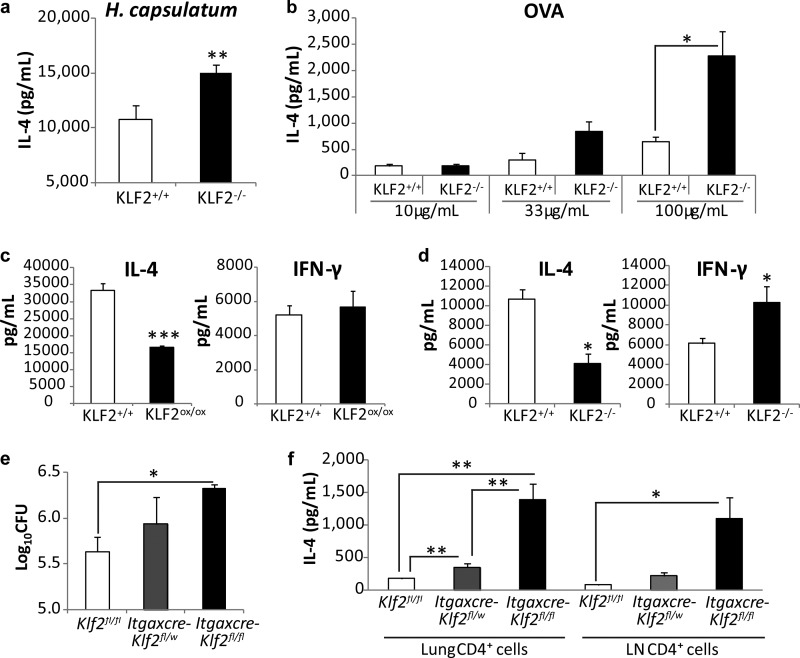
KLF2 in DCs dictates the strength of the Th2 response. (a and b) IL-4 production by naive cognate T cells after 5 days of coculture with 2 HK H. capsulatum yeast cells/BMDC (a) or 100-µg/ml OVA-pulsed BMDCs (b) and an additional 24 h of restimulation (summary of 4 to 6 experiments). *, P < 0.05, and **, P < 0.01, for comparison with the results for the control by Student’s t test. (c) IFN-γ and IL-4 production by T cells cocultured with KLF2ox/ox BMDCs (3 experiments). (d) IL-4 and IFN-γ production by T cells cocultured with BMMφs (3 experiments). (e) Lung fungal burdens in control, Itgaxcre-Klf2fl/w (w = wild-type allele), and Itgaxcre-Klf2fl/fl mice at day14 p.i. (n = 4 or 5). (f) IL-4 production by CD4+ cells isolated from the lungs and LNs of H. capsulatum-infected mice at day 14 p.i. and restimulated for 24 h ex vivo (n = 5 or 6). *, P < 0.05, and **, P < 0.01, by Student’s t test or one-way ANOVA. Data represent the mean results ± SEM.